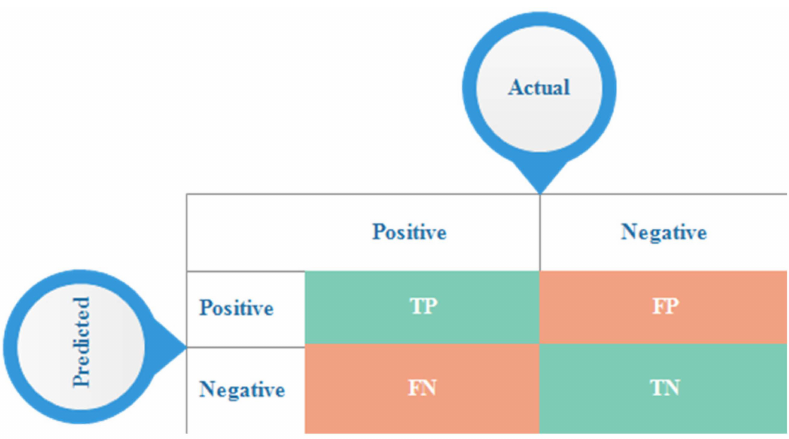
Figure 7. Confusion matrix